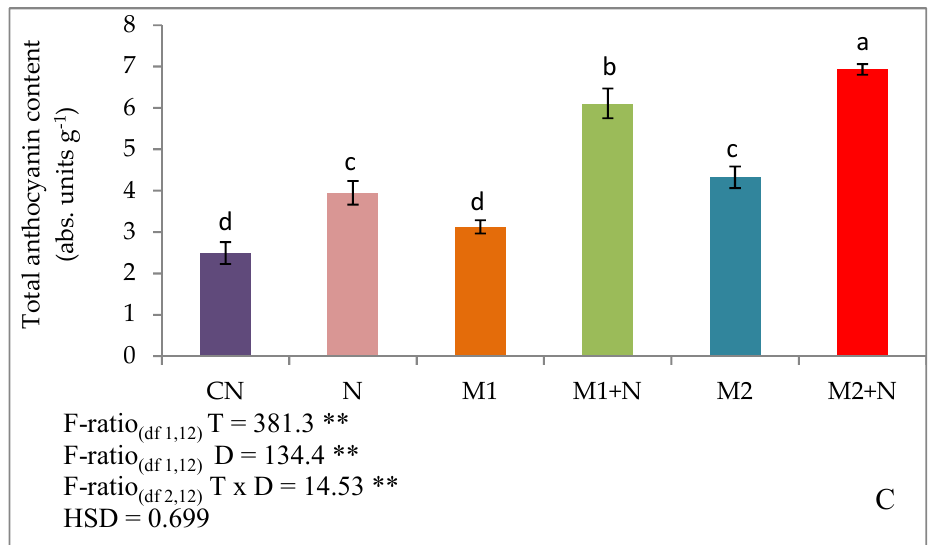
Figure 4. E ff ect of M1 (10 9 cells / mL) and M2 (10 9 cells / mL) on Phenolic compounds ( A ) Total Phenols ( B ) Total Flavonoids ( C ) Total Anthocyanins in 45-days old L. esculentum under PPN infection. Data is presented as means of three replicates ± SD and HSD values. F ratio values, * indicates significance at p ≤ 0.05 and ** indicates significance at p ≤ 0.01). Di ff erent letters on the table indicate that mean values of treatments are significantly di ff erent at p < 0.5 according to Tukey’s multiple comparison